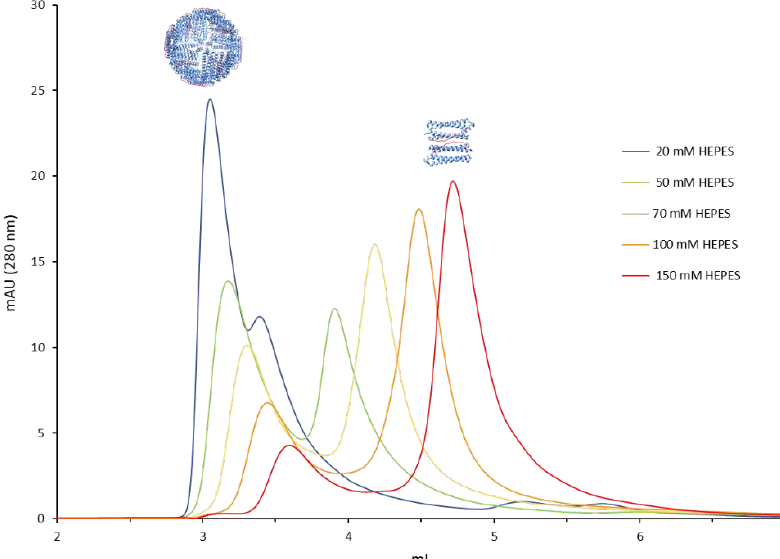
Figure 5. Effect of HEPES buffer concentration on HP-SEC analysis of purified HumFt R150A/K151A. Increasing HEPES buffer concentration from 20 mM to 150 mM leads to a better resolution of 24-mer and dimer, shifting at the same time the equilibrium towards the dimeric form.